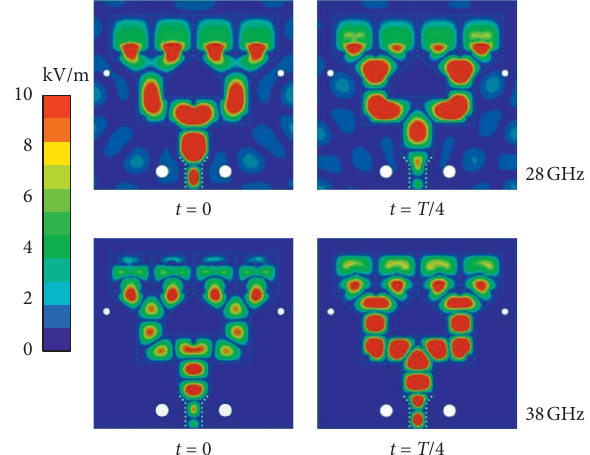
Figure 10: Distributions of the E-feld of the proposed antenna array.